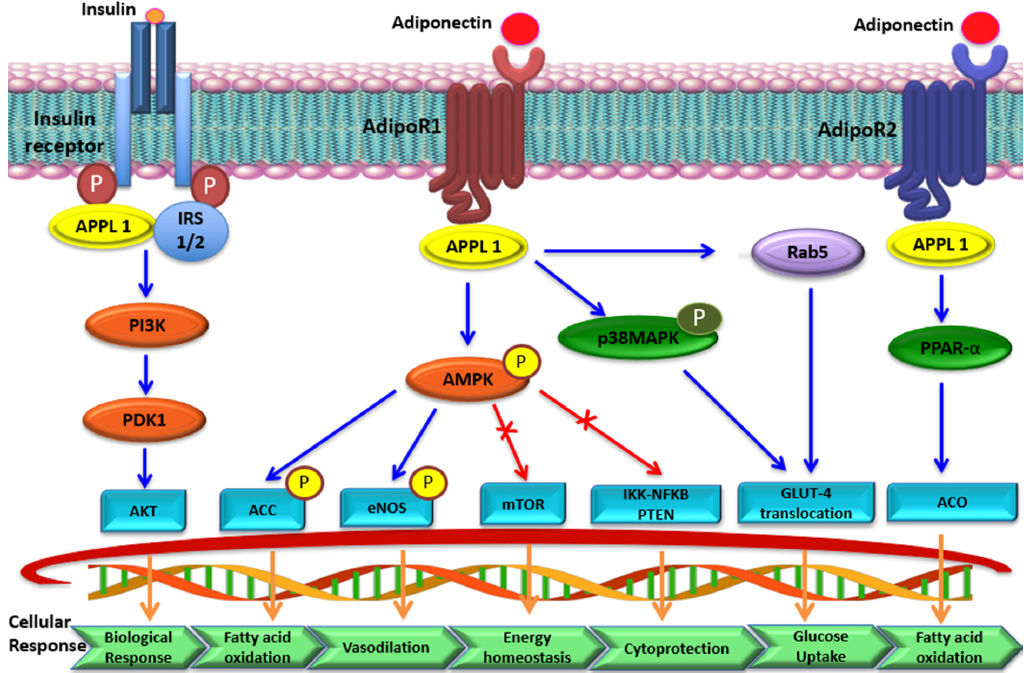
Figure 3. Key signaling pathways of adiponectin. Adiponectin and AdipoRs (AdipoR1 and AdipoR2) interact to activate downstream signaling pathways. Binding of adiponectin to its receptors activates adaptor protein APPL1. Activated APPL1 initiates complex signal transduction by activating PPAR- α and phosphorylating AMPK and p38-MAPK. Phospho-AMPK inhibits lipogenesis and